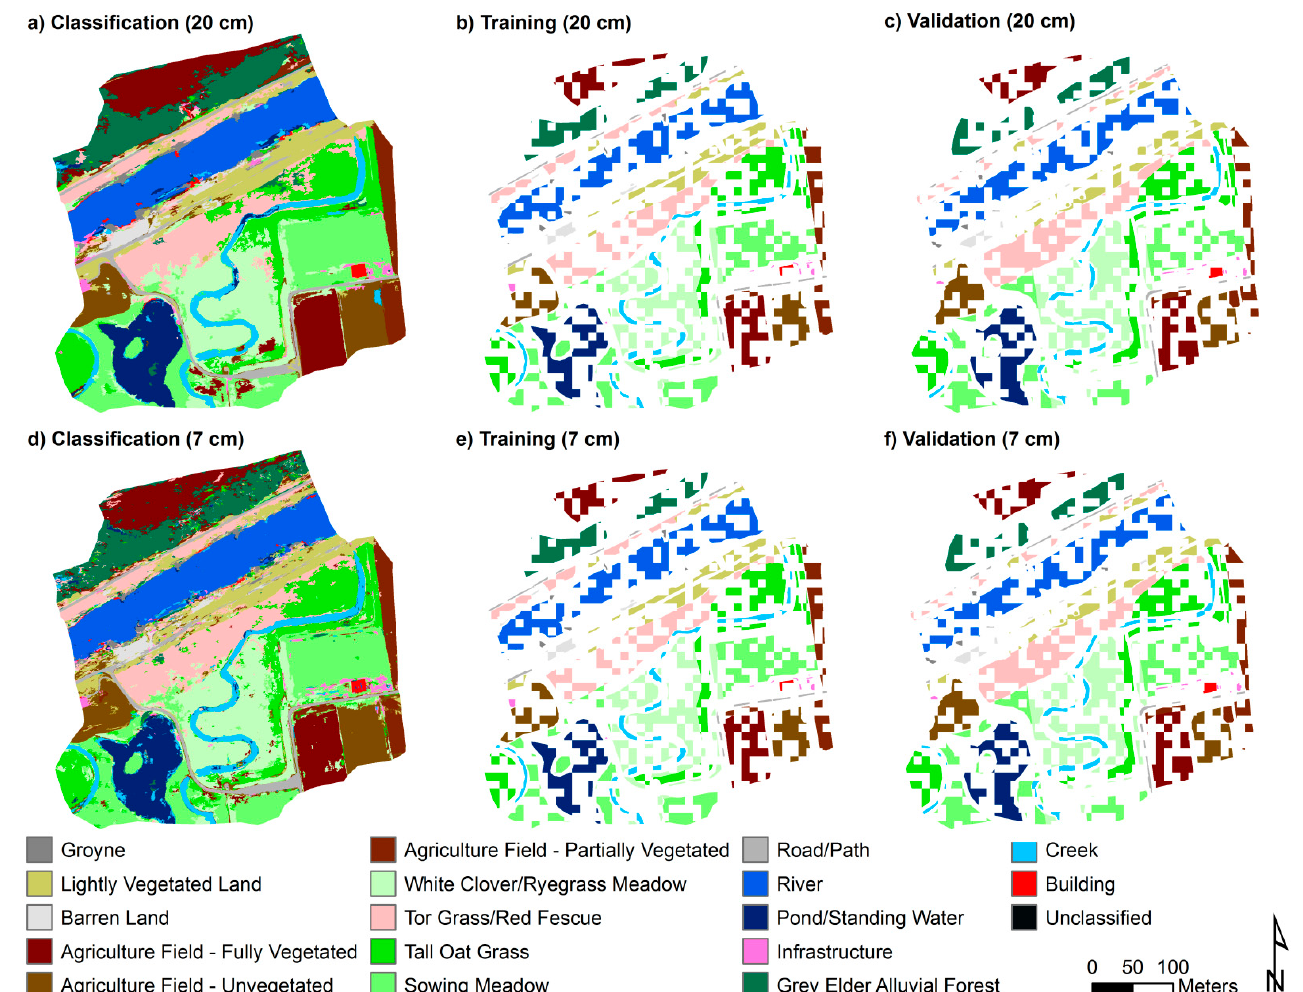
Figure 8. ( a ) Land cover classification of the 20 cm pixel size narrow-band 22 June 2016 image of the River Gail generated using eCognition ® ; ( b ) Training data used in eCognition ® for generating the land cover image in ( a ); ( c ) Validation data used in the accuracy assessment of the land cover image in ( a ); ( d ) Land cover classification of the 7 cm pixel size narrow-band 22 June 2016 image of the River Gail generated using eCognition ® ; ( e ) Training data used in eCognition ® for generating the land cover image in ( d ); ( f ) Validation data used in the accuracy assessment of the land cover image in ( d ).